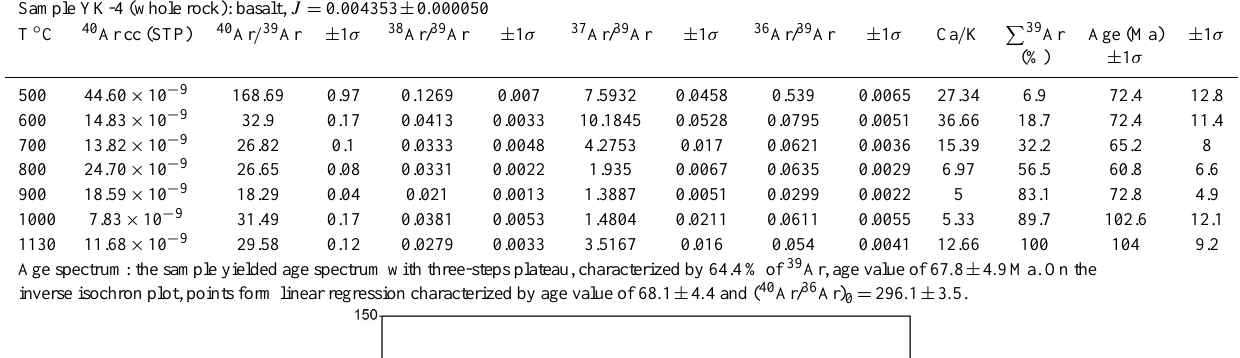
Table 4a. Whole-rock 40 Ar/ 39 Ar age data for an island-arc basaltic rock (Sample No. YK- 4) in the Ankara Mélange, Turkey. 967 Sample: YK- 4 (whole rock): Basalt, J=0.004353±0.000050